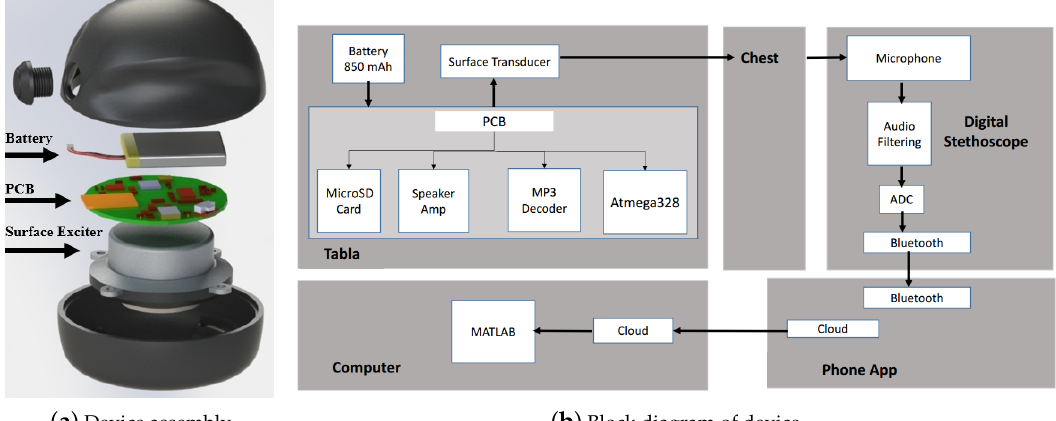
Figure 2. ( a ) the components of the device from top to bottom: 3D-printed plastic enclosure, button to start signal generation, Lithium polymer battery, printed circuit board (PCB), surface exciter; ( b ) the device prototype has four major components. Tabla transmits automated input into the chest and the Eko Core stethoscope (Eko Devices, Berkeley, CA) records output from the subject’s back. The sound files are transmitted from the stethoscope via Bluetooth and recorded using a smartphone app; the data are then stored on the cloud, as described in Section 2.5. Figure from